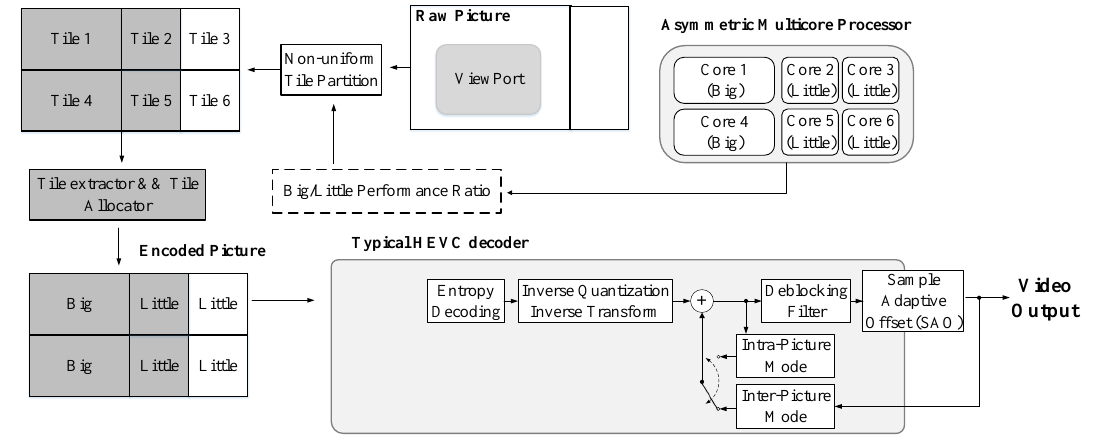
Figure 7. Block diagram of the proposed Tile-SHVC encoding/decoding